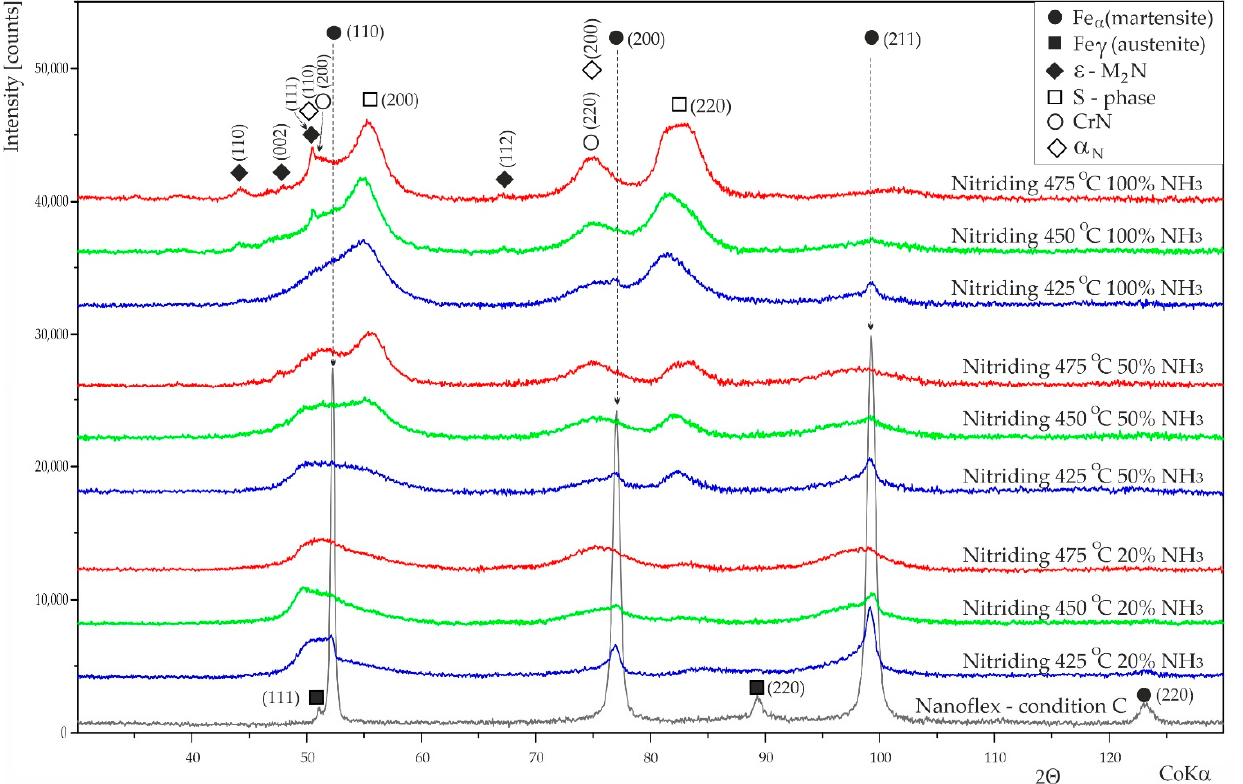
Figure 7. X-ray diffraction patterns of nitrided layers with various parameters and untreated Nanoflex steel in condition C. (Intensity of every next pattern has been shifted up 4000 counts from the previous pattern).